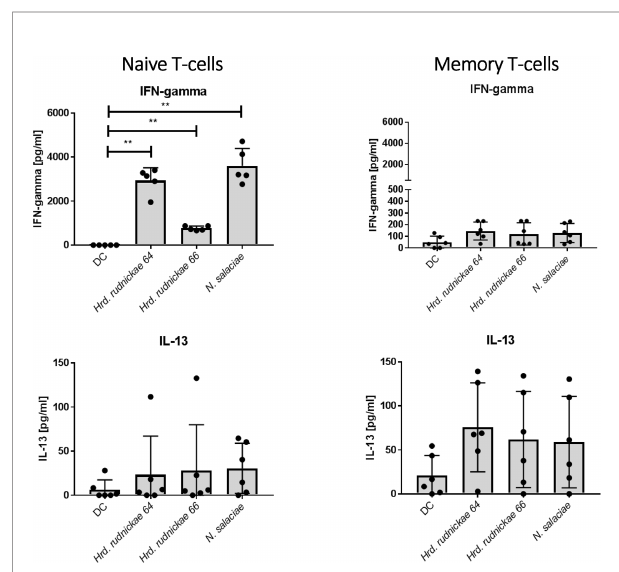
FIGURE 4 | Cytokine secretion by naïve and memory CD4 + T cells co- cultured with halophile-stimulated DCs. Secretion of IFN- g and IL-13 by human naïve (left panels) and memory (right panels) T cells following 96 h coculture with Hrd. rudnickae 64- , Hrd. rudnickae 66- or N. salaciae- pulsed autologous DCs (ratio DCs/T cells, 1:10) was measured in duplicates by ELISA. Data shown represent the means ± SD of 7 donors. Statistical analyses were performed using the Mann – Whitney U test for unpaired data . **p < 0.01 versus control (unstimulated DC).